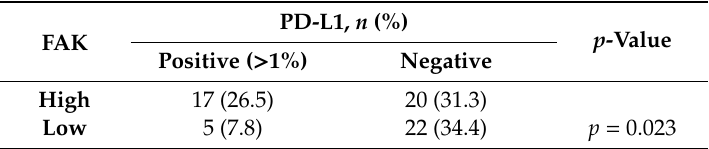
Table 1. Association of FAK and PD-L1 expressions in TNBC